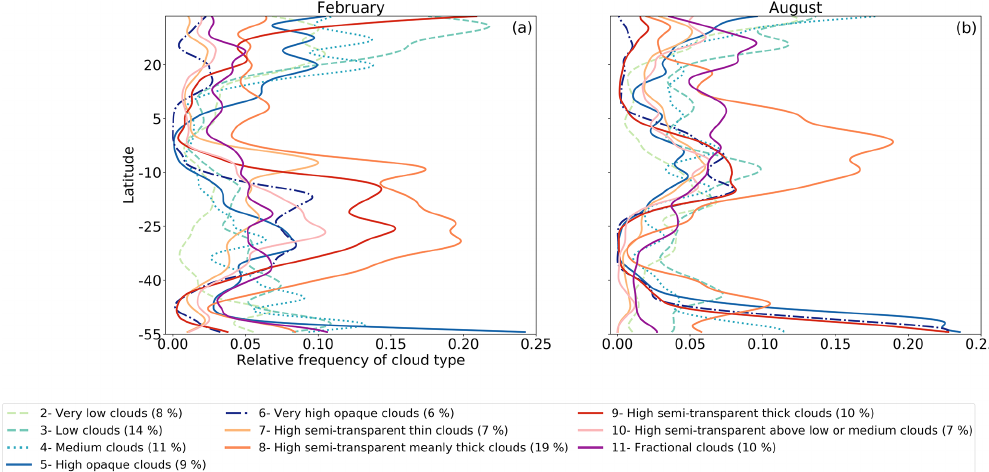
Figure 1. Relative frequency of cloud types as a function of latitude for February (a) and August (b) 2015 over land within the SEVIRI disk. The average frequency of each cloud type over these 2 months is indicated in the legend.